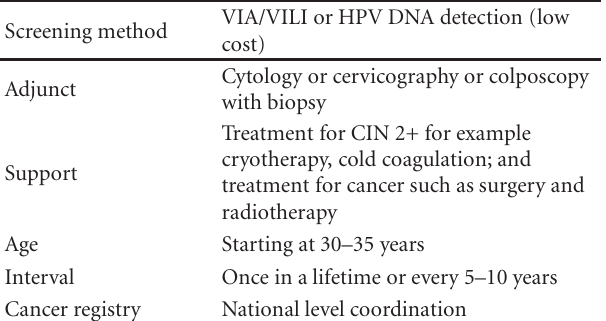
Table 2: Key elements to be considered in choosing a screening strategy for high-resources